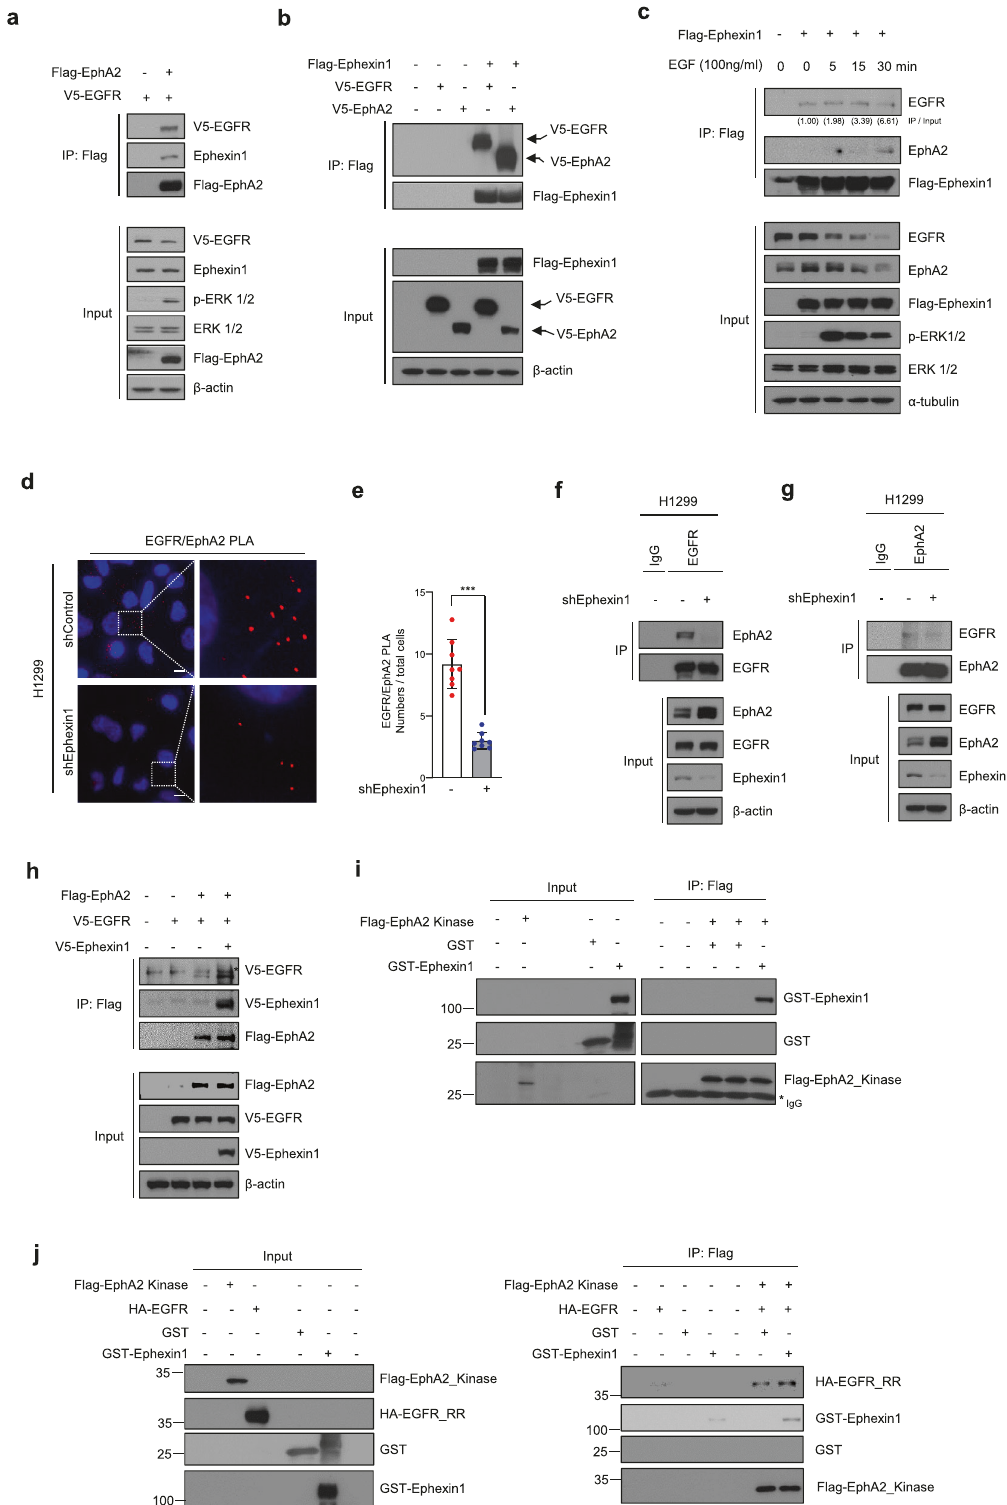
and analyzed the survival rates of lung cancer and colorectal cancer patients relative to the expression levels of all four proteins. In an analysis of survival rates among lung cancer patients, the higher the expression of Ephexin1, EGFR, EphA1, and EphA2, the lower the rate (Fig. 1c). In contrast, the lower the expression of EphA3, EphA4, and EphA5, the worse the survival rate